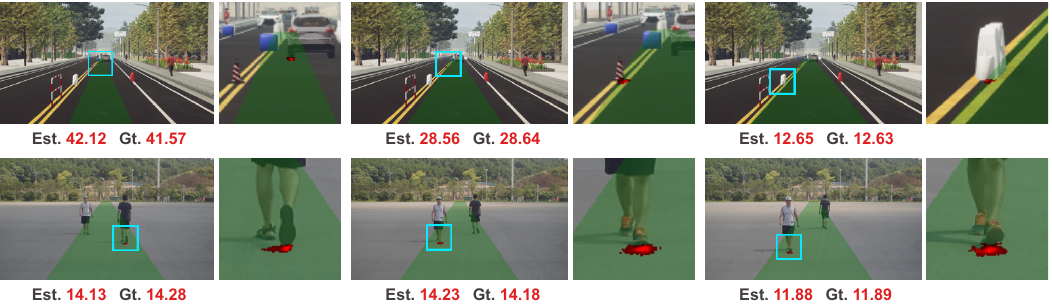
Figure 9. Results on images with multiple objects in